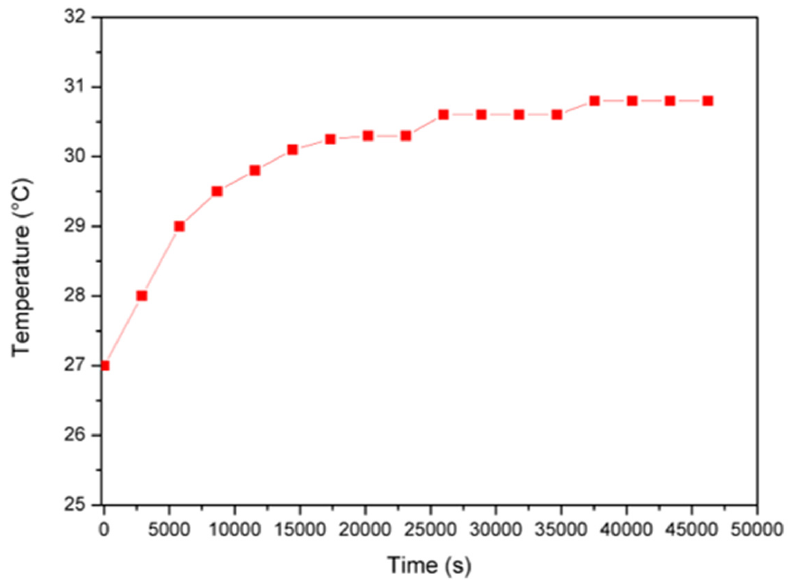
Figure 10. Evolution of the temperature obtained during the measurements campaign.